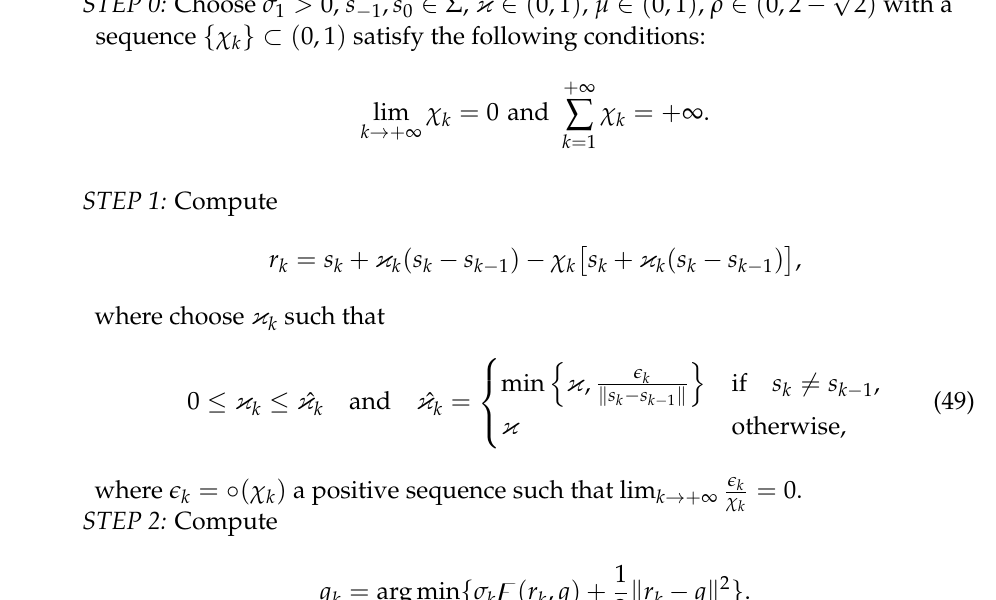
Algorithm 4: Explicit Extragradient Method With Non-Monotone Stepsize Rule